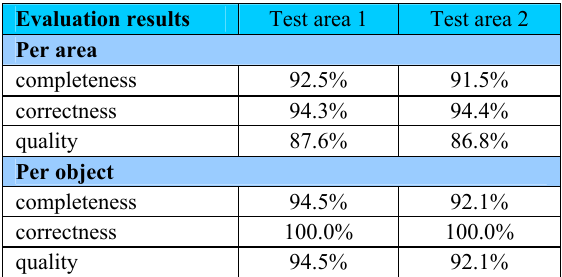
Table 1. Evaluation of the building detection results.